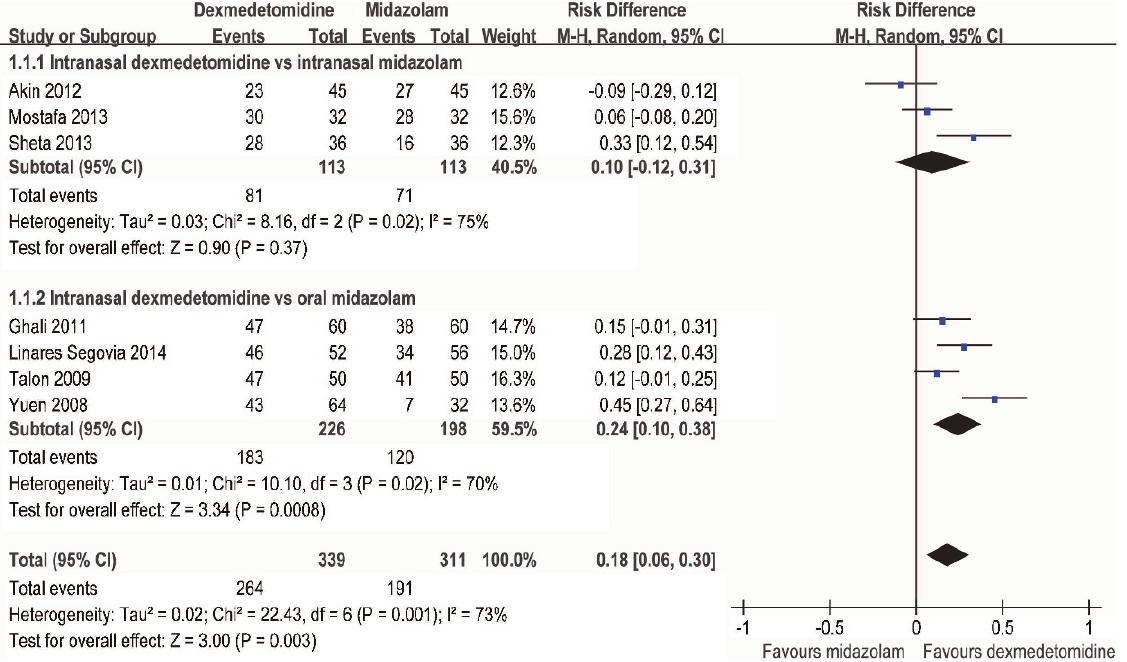
Figure 2 - Meta-analysis of satisfactory separation from parents in children treated with dexmedetomidine vs .